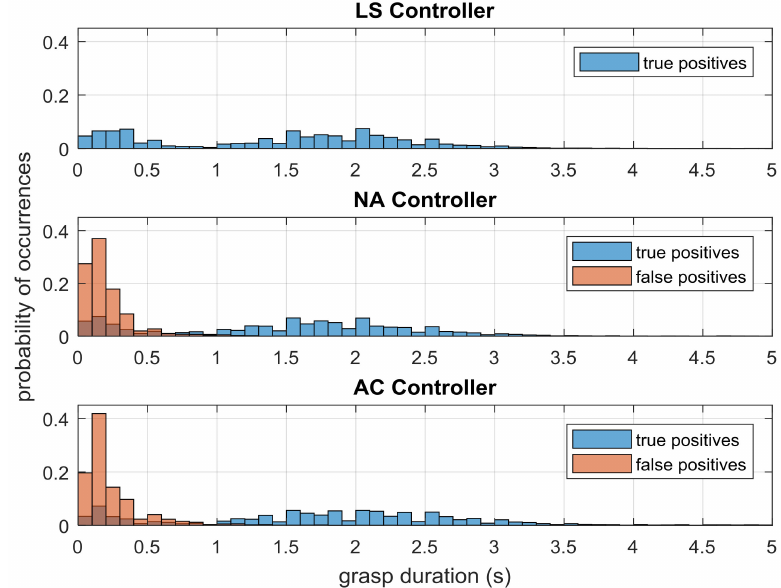
Figure 9. Histogram of positive response times shows that true positives are bimodal and that the shortest actuation durations are dominated by false positives. Only grasps shorter than 5 s are shown, but grasps that were longer than 5 s occurred for LS ( n = 7), NA ( n = 1), and AC ( n = 24)